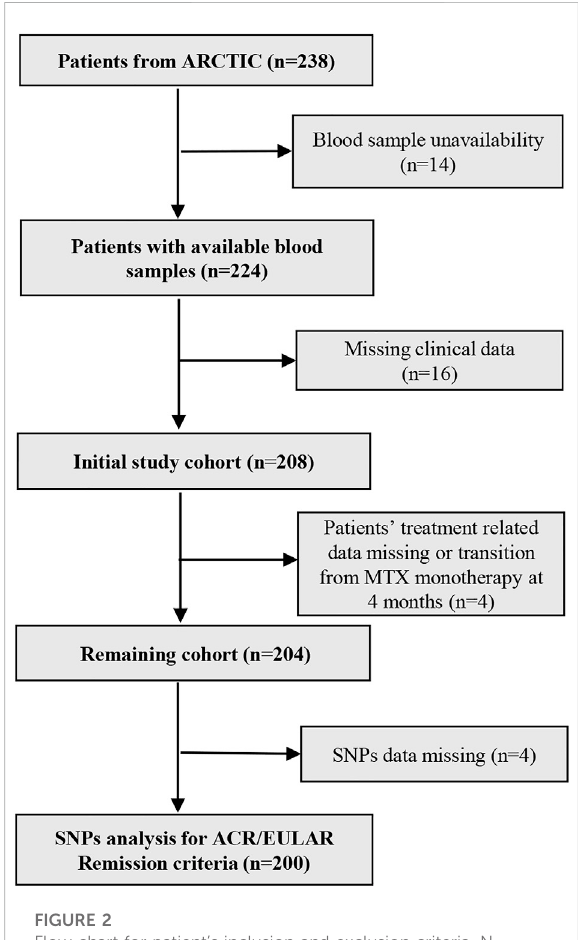
FIGURE 2 Flow chart for patient ’ s inclusion and exclusion criteria.